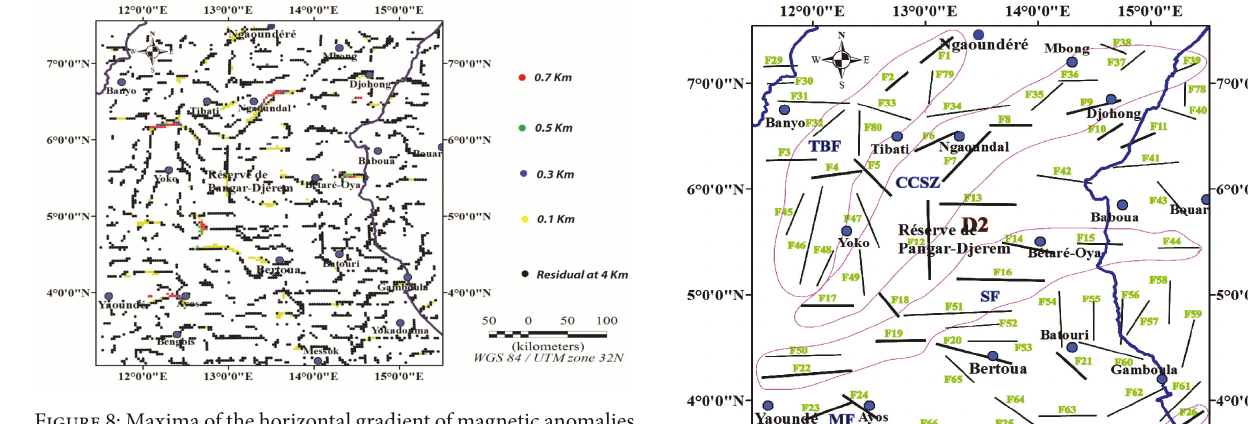
Figure 8: Maxima of the horizontal gradient of magnetic anomalies map upward continued to 4.1, 4.3, 4.5, and 4.7 km.